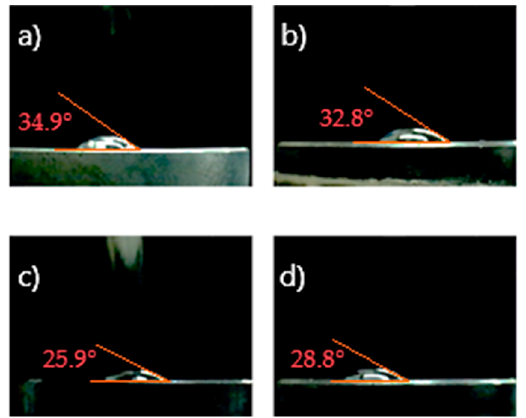
Figure 4. Drops of PAO 8 oil snapshots at 0.06 s on the surfaces: ( a ) CrN, ( b ) Ar-DLC, ( c ) 25% Ne-DLC and ( d ) 50% Ne-DLC.